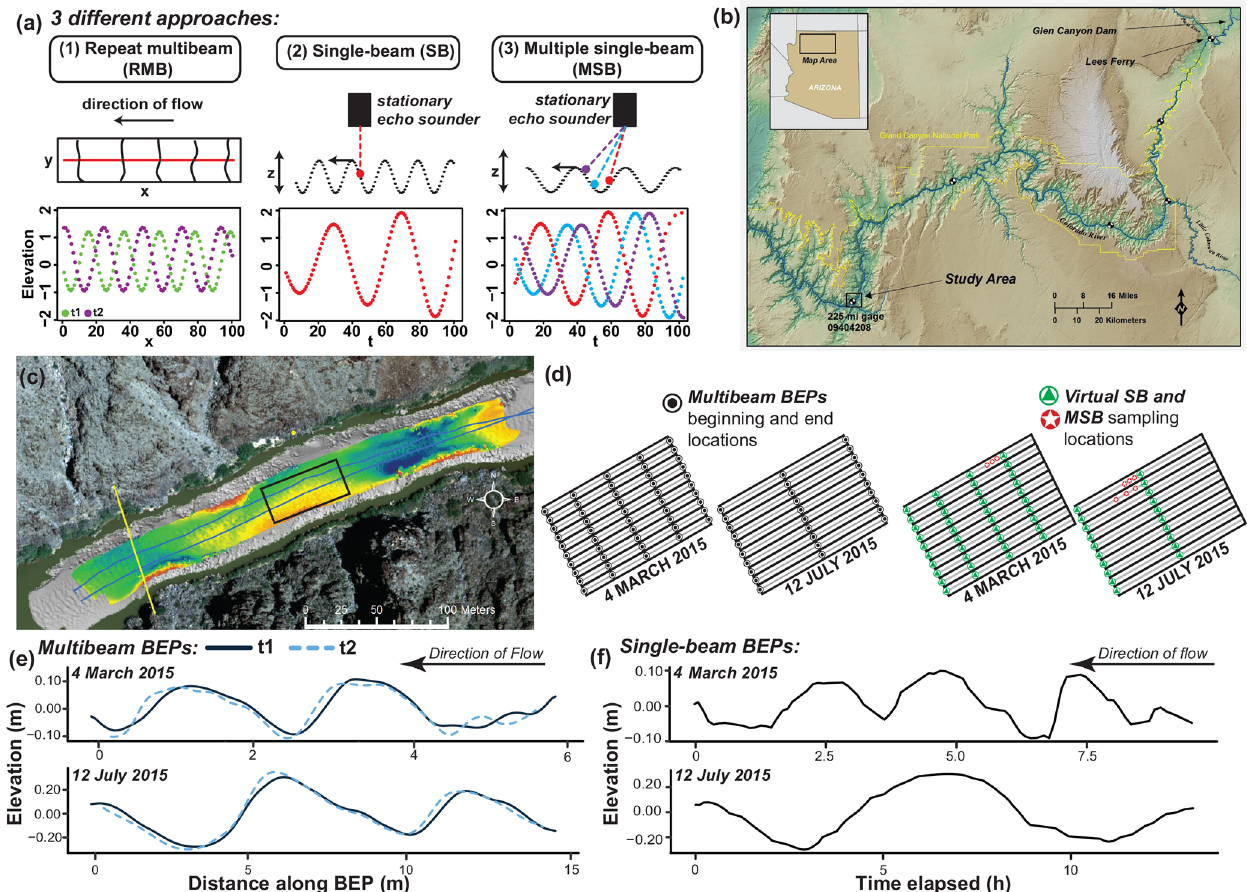
Figure 1. (a) Schematic of three common field methodologies for collecting BEPs (repeat multibeam, single-beam, and multiple single beam) and the types of BEPs produced by each method. (b) Location of study area on the Colorado River in Grand Canyon National Park. Map adapted from Kaplinski et al. (2017). (c) Map of study reach. Yellow line indicates the location of the Diamond Creek USGS gage. Gray area indicates area mapped with single multibeam survey. Colored area indicates area over which repeat multibeam surveys were collected (colors indicate elevations where red is high and blue is low). The blue lines that bisect the repeat multibeam survey area indicate the track lines the boat drove along in order to obtain each survey. Black rectangle indicates area in which BEPs were extracted. (d) BEP extraction map for multibeam, virtual single beam, and virtual multiple single beam. Examples of repeat multibeam (e) and single beam (f) BEPs for March and July